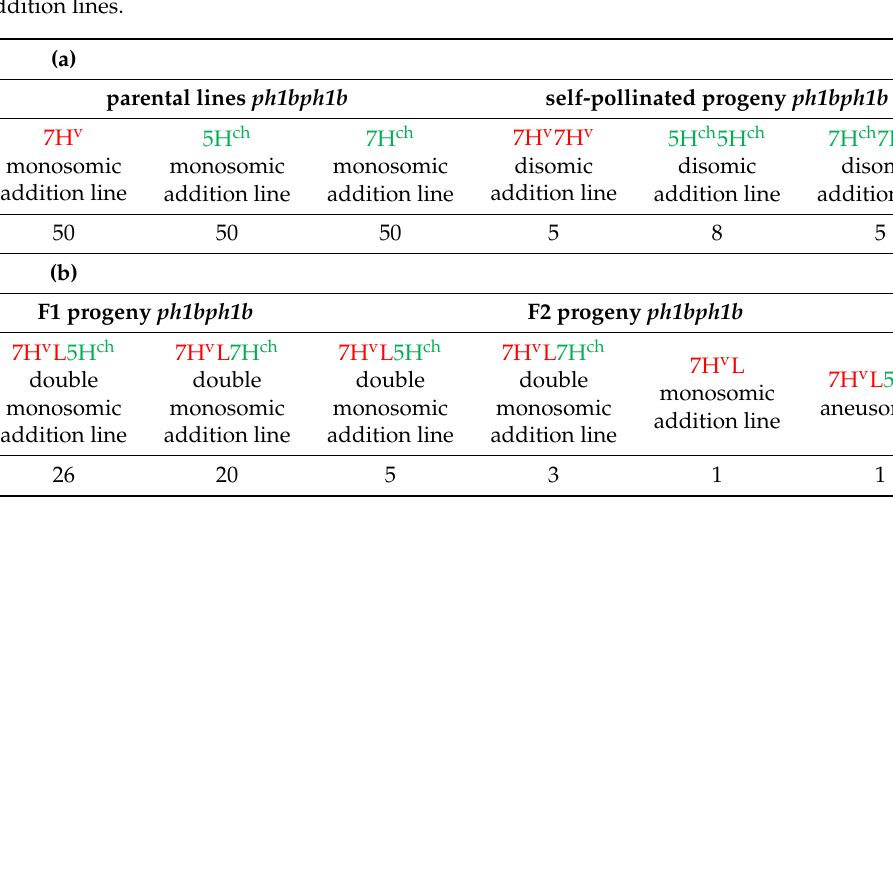
Table 1. ( a ) Plants used for genetic crosses to develop wheat lines carrying a Hordeum disomic addition in the ph1b mutant background. ( b ) Plants obtained after genetic crosses between disomic addition